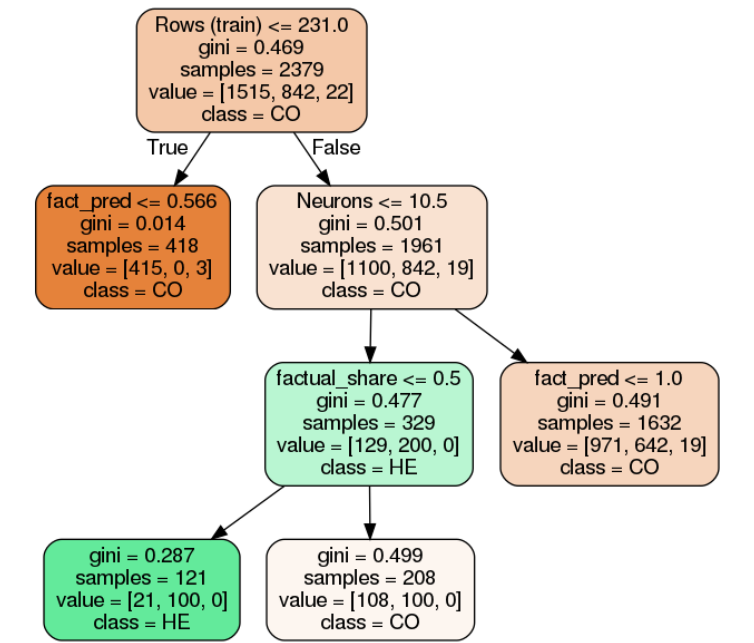
Figure 8. Decision tree to decide which algorithm implementation pattern performs best in realistic